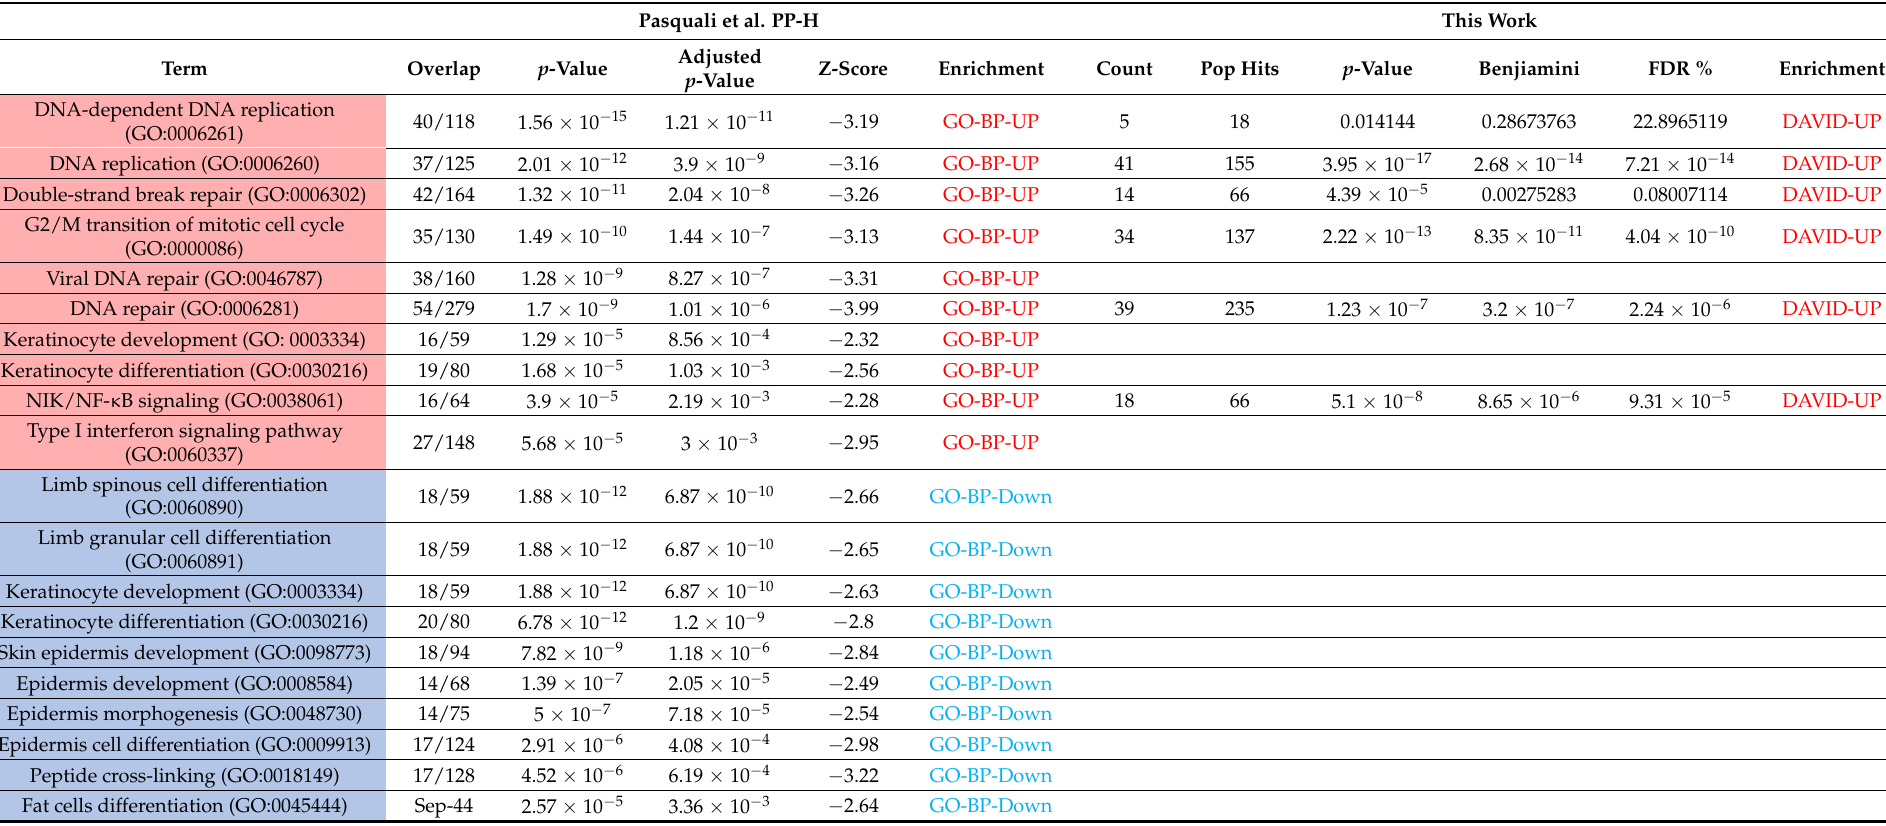
Table 2. Comparative table with GO terms comparing the data from Pasquali et al., 2019 [9] and this work. Red: upregulated DEGs; blue: downregulated DEGs. Pasquali et al.